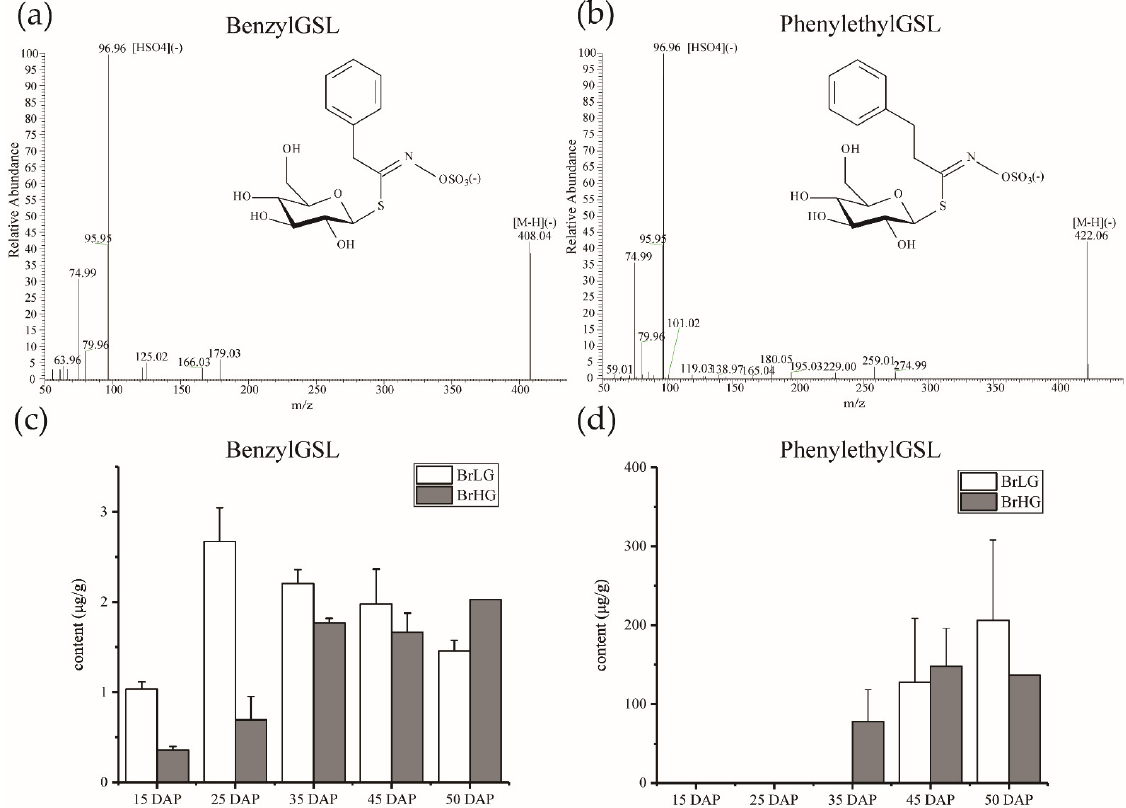
Figure 1. Characterization of Phe-derived GSLs in developing seeds of B. rapa . The fragmentation pattern ( a , b ) and dynamic accumulation ( c , d ) of benzylGSL and phenethylGSL in developing seeds of B. rapa . BrLG, B. rapa with low content of GSLs; BrHG, B. rapa with high content of GSLs. The content referred to the micrograms of GSL anion in per gram of fresh seed